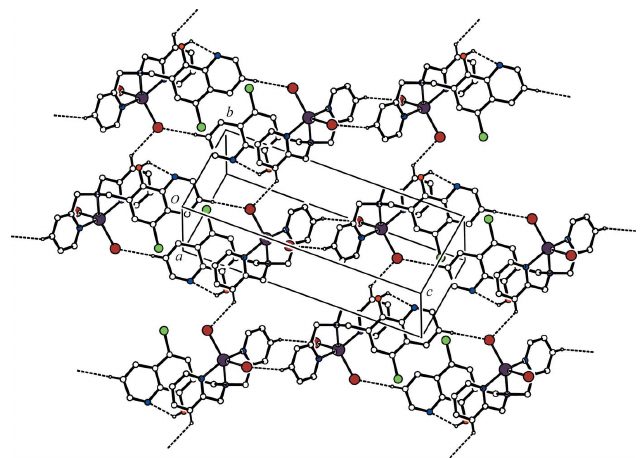
Figure 3 A packing diagram of the title compound showing the two-dimensional network sheet structure. The intermolecular C—H (cid:2)(cid:2)(cid:2) Br and intra- molecular O—H (cid:2)(cid:2)(cid:2) N hydrogen bonds are shown as dashed lines. H atoms not involved in the interactions were omitted for